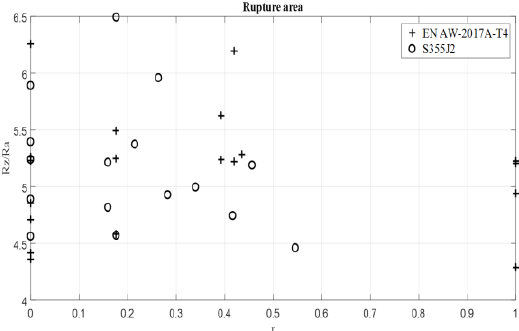
Fig. 11. The Rz/Ra factor relationship to r parameter, for rupture